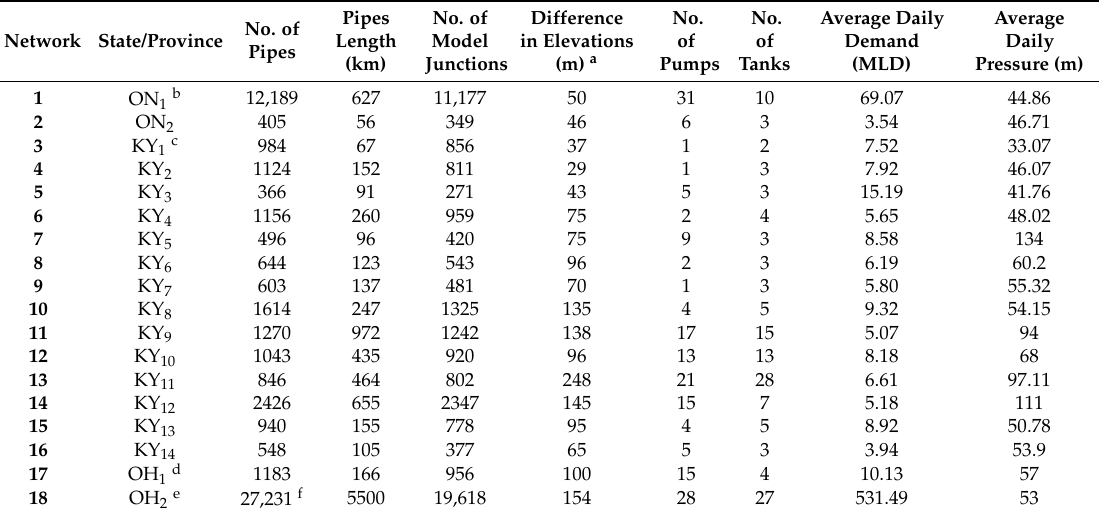
Table 2. Summary of characteristics of 18 North American WDSs.